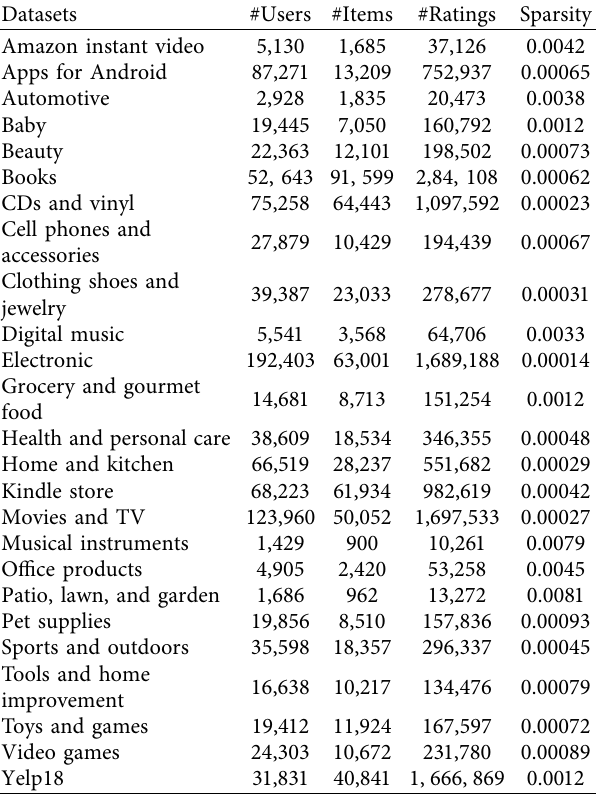
Table 2: Statistics of the twenty-five